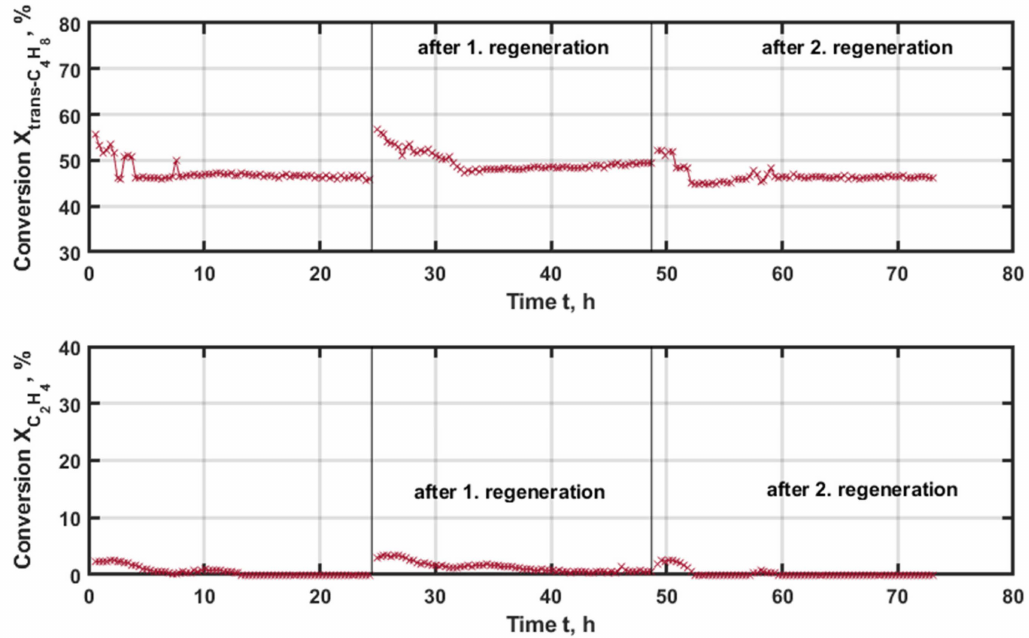
Figure 7. Conversion of the applied reactants trans-butene (upper graph) and ethene (lower graph) with time-on-stream (TOS) applying NiRe/mix (1:1) as the catalyst at 225 ◦ C and 500 kg cat · s · m − 3 , with regeneration at 500 ◦ C and 20% oxygen for 3